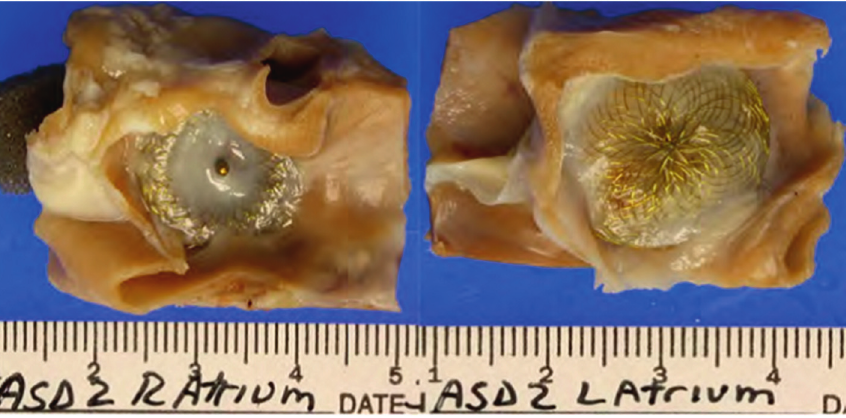
Figure 1: ASD device uncoated.